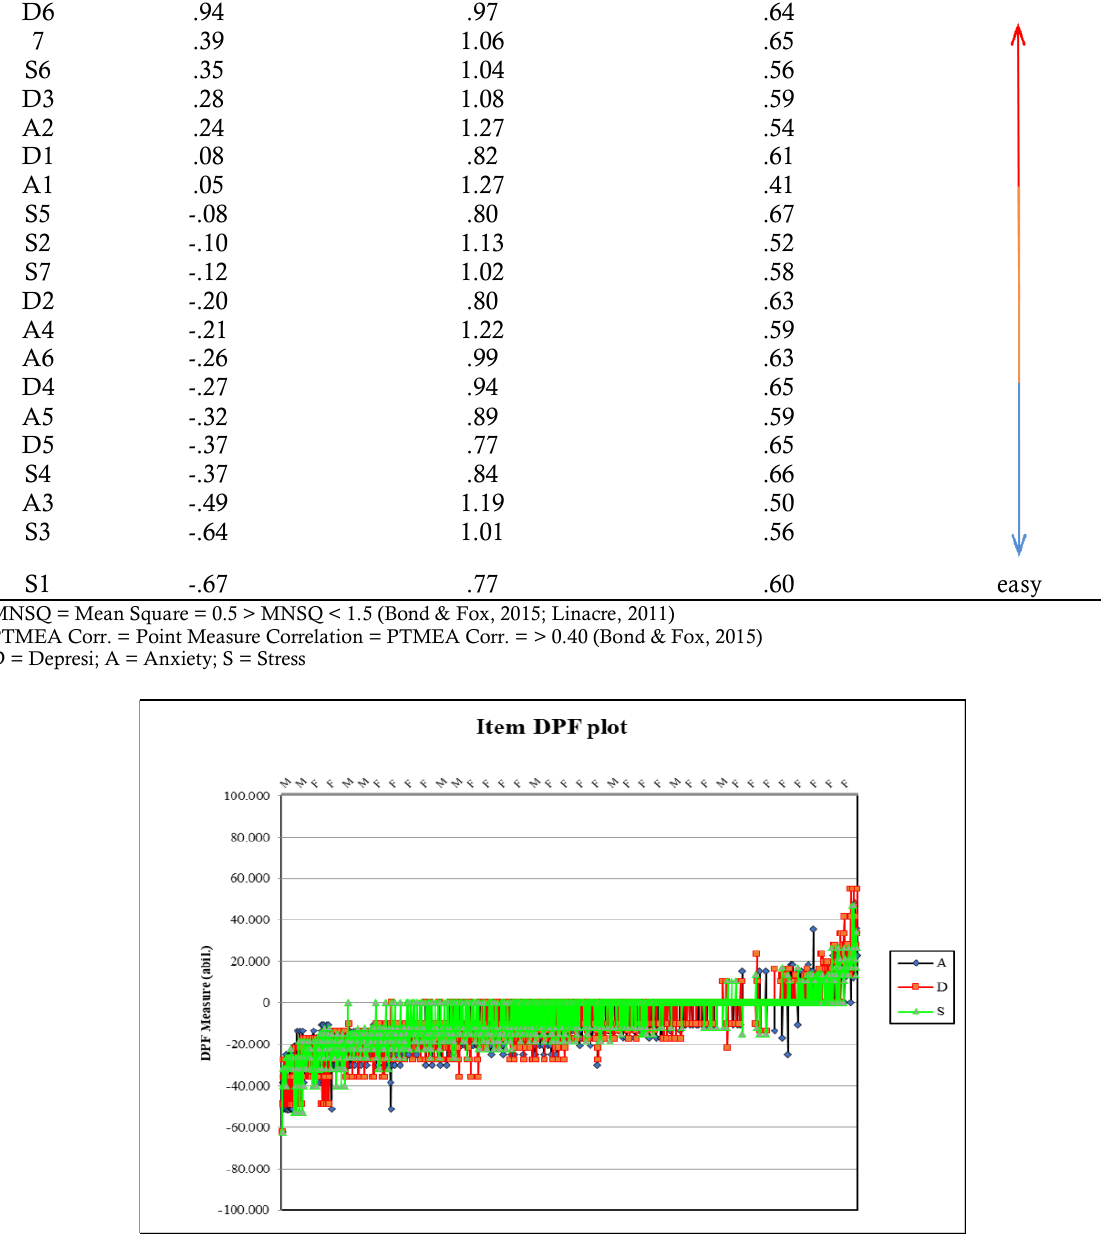
Figure 2. Differential Person Functionality (DPF) Rating Scale